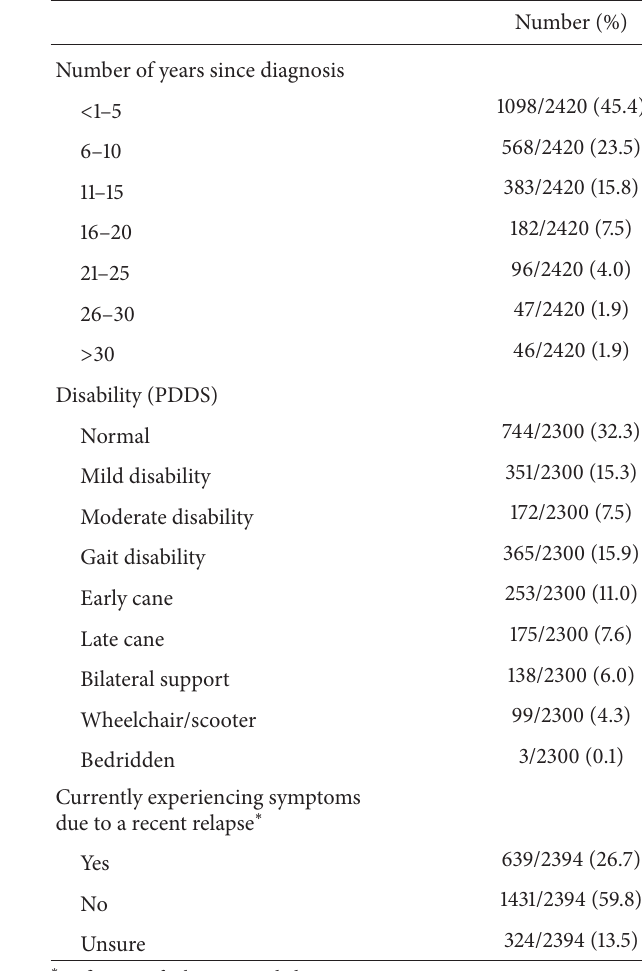
Table 4: Diagnostic characteristics and level of